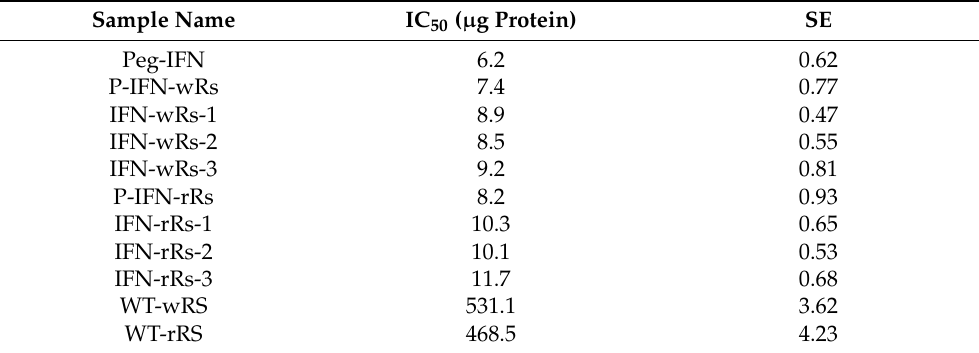
Table 2. Cytotoxicity effect of recombinant INF α 2a against Hep-G2 cell